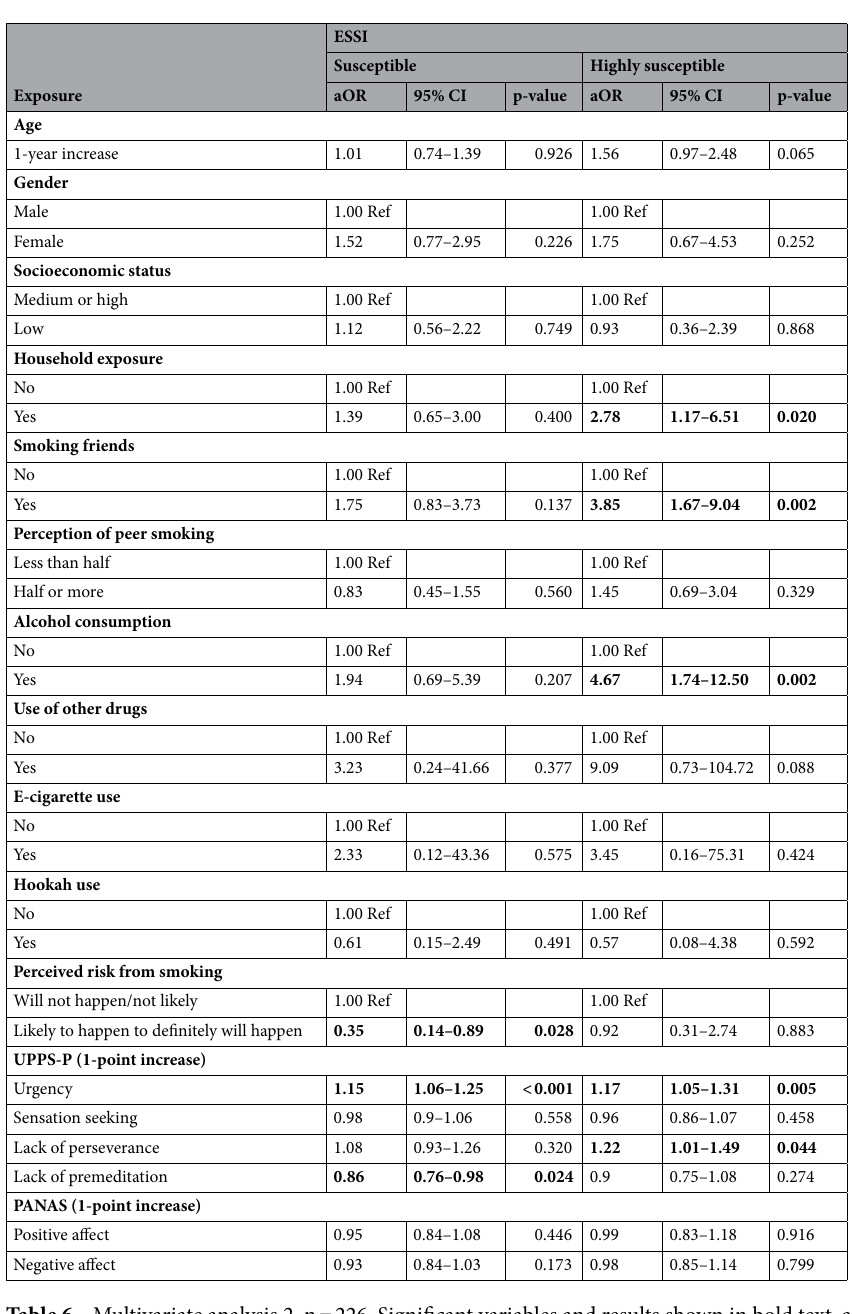
Table 6. Multivariate analysis 2. n = 226. Significant variables and results shown in bold text. aOR: adjusted odds ratio; 95% CI: 95% confidence interval; Ref.: reference; ESSI: expanded susceptibility to smoking index; UPPS-P: impulsive behaviour scale; PANAS: positive and negative affect